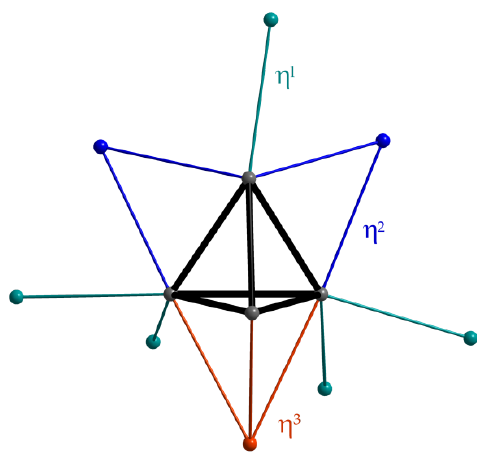
Figure 8. Different coordination modes of cations shown on the example of NaPb. Table 4. Coordination number of the [E 4 ] 4− cages in NaPb and related compounds. Table 5. Coordination number of the cations in NaPb and related